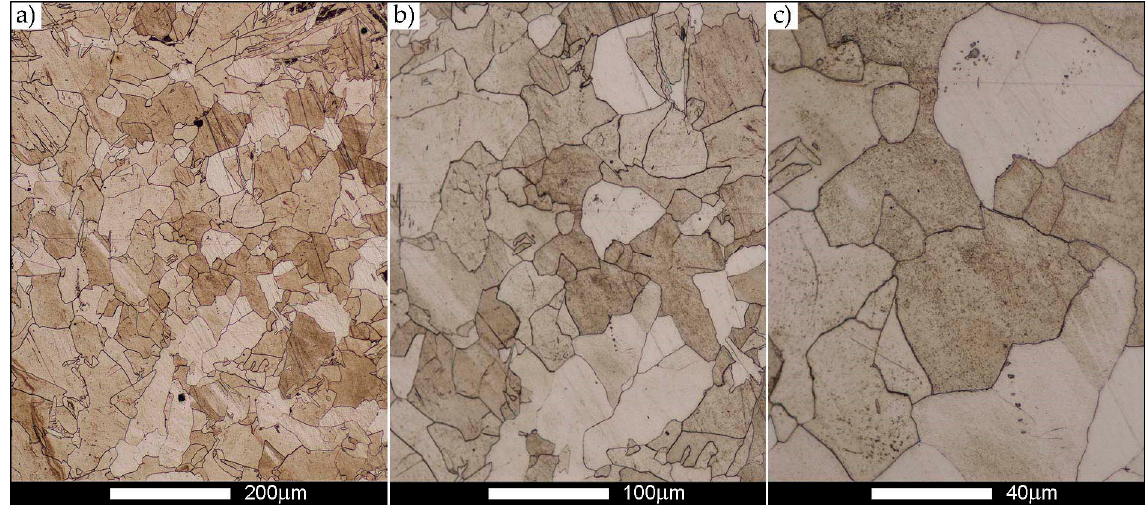
Figure 27. Microstructure of welded joint of Hardox 450 steel with revealed grain boundaries of prior austenite, austenitised at 1200 °C—BM zone shown in Figure 2. ( a ) 100×; ( b ) 200×; ( c ) 500×.